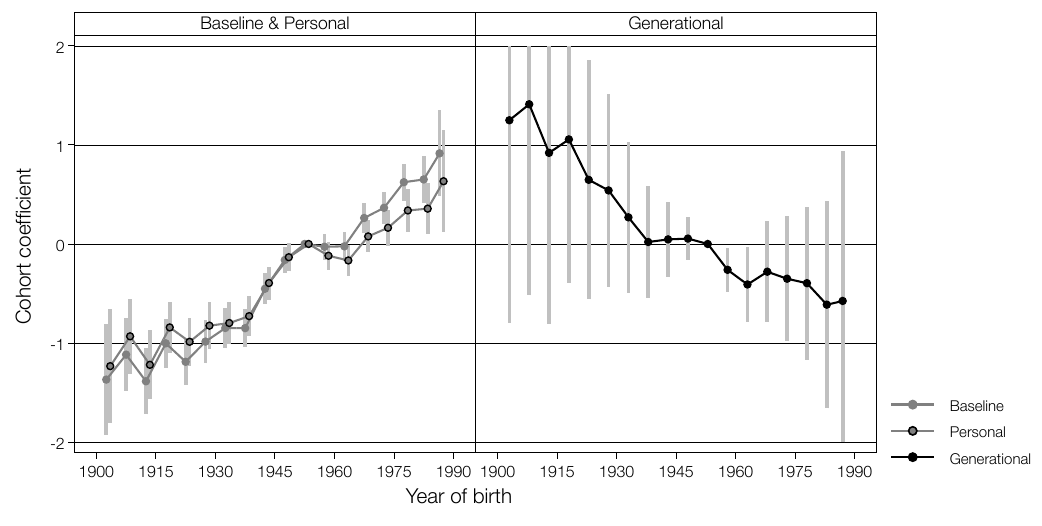
Figure 7: Patterns of Cohort Variation in the Baseline, Personal, and Generation Model: Persons, 25 years Old and